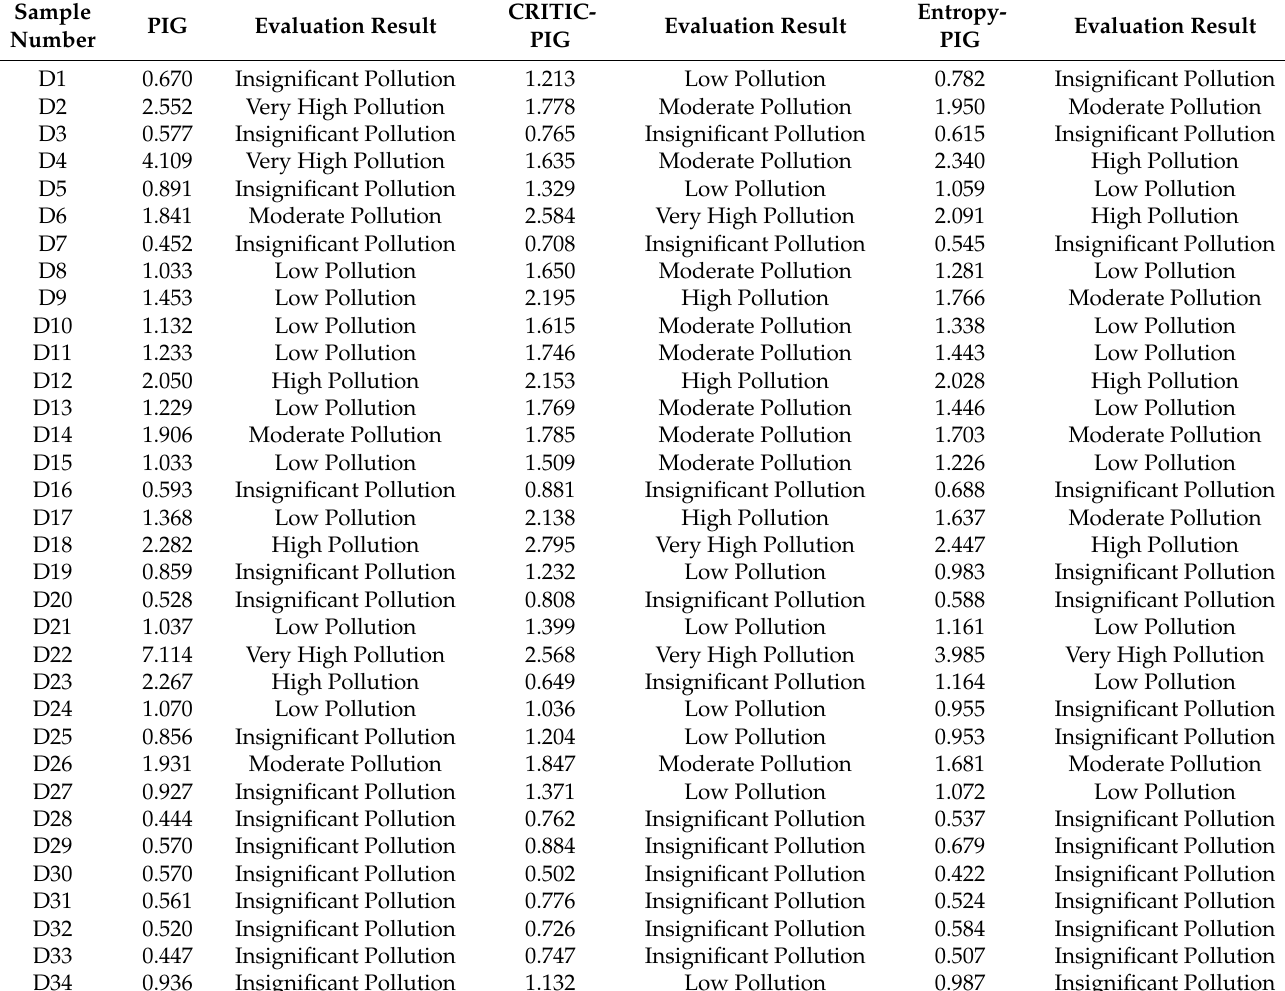
Table 5. Three PIG values and evaluation results of 34 unconfined groundwater